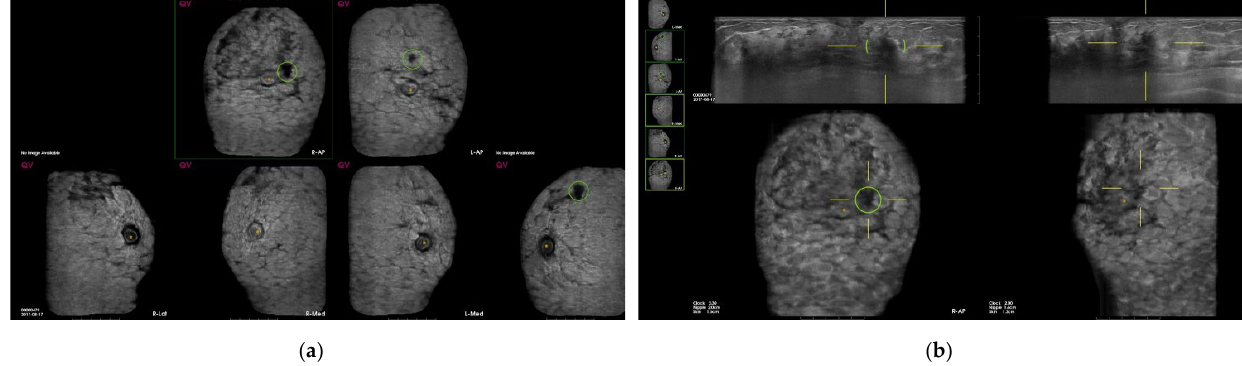
Table 3. Number and characteristics of computer-aided detection (CAD) mark.